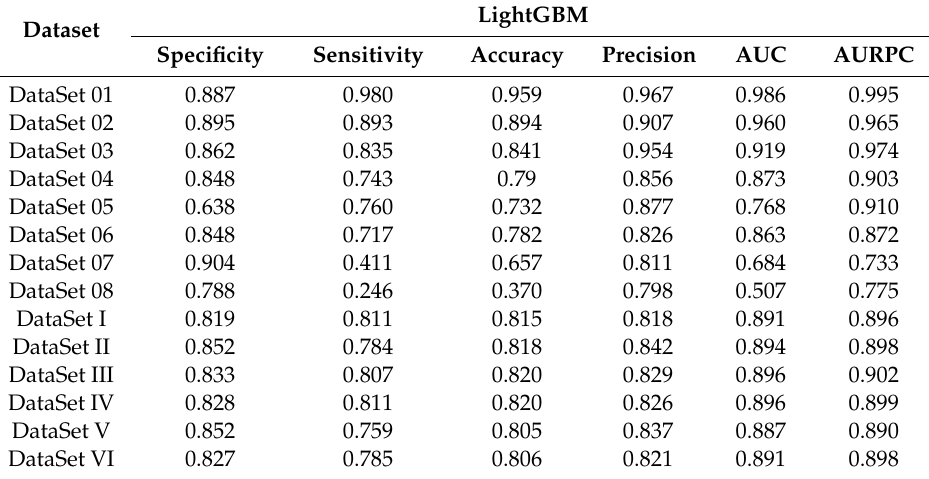
Table 4. Performance comparison between thirteen datasets on the method LightGBM.